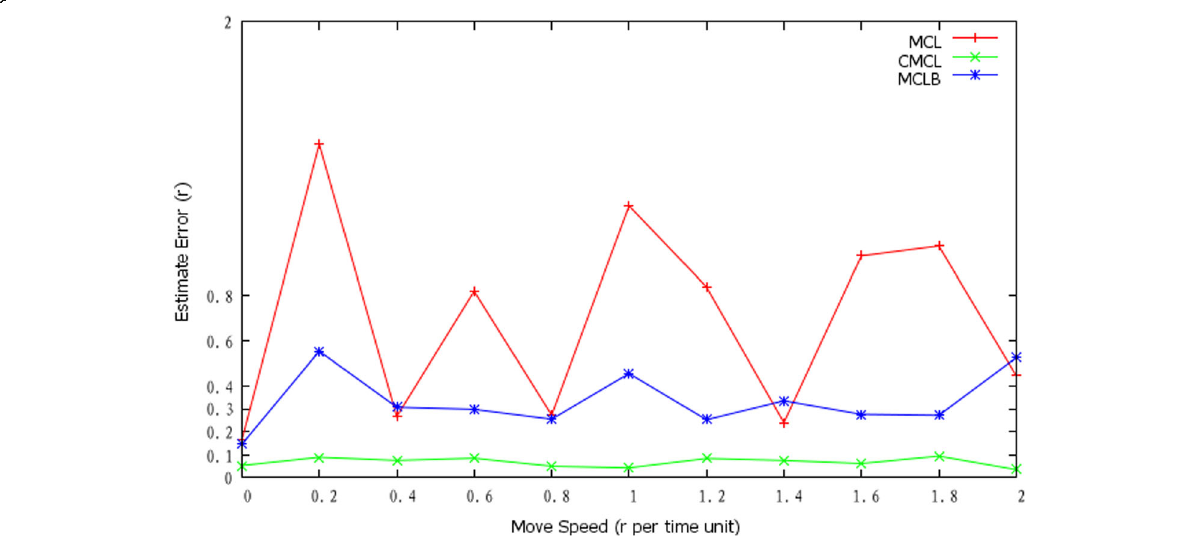
Fig. 5 Anchor node by 25-m interval comparison chart. From the top anchor node, the spacing was 25 m and 10 m; charting to see when a node moving speed changes from 0 m to 100 m accuracy; when you can see the positioning accuracy is approximately 25 m at about 25%; and when the accuracy is